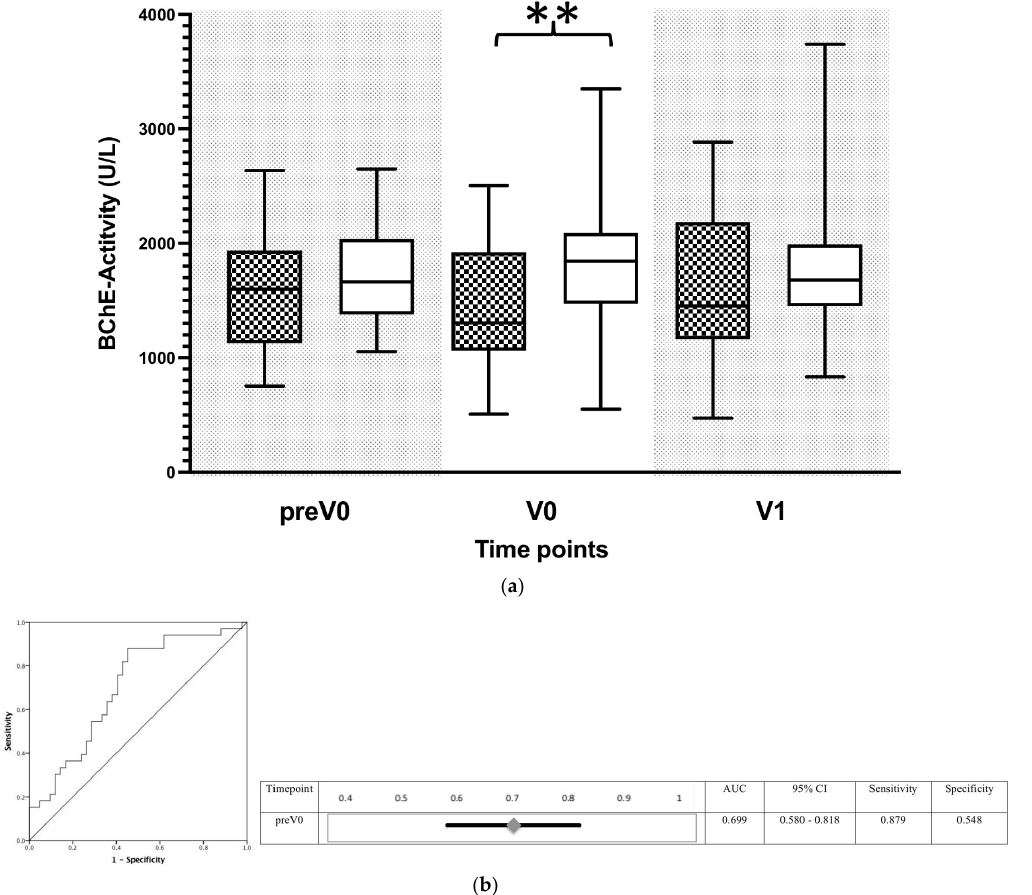
Figure 3. Plasma concentrations of butyrylcholinesterase (BChE) in patients following liver trans- plantation adjusted to the timepoint of bacterial infection. ( a ) Plasmatic BChE activity was measured in patients following liver transplantation. Measurements in patients with bacterial infection were adjusted to the timepoint of appearance (black squared box) and then compared to non-infected patients (white box). In patients with a bacterial infection, new timepoints were assigned by match- ing them to the first time of bacterial infection, whereas the control group without bacterial infection was assigned by matching them in an age- and sex-related manner to the same timepoints as pa- tients with a bacterial infection. The following virtual timepoints were created: the first measure- ment before the first bacterial infection (preV0), the plasma level at the time of bacterial infection (V0) and the next measured plasma level (V1). BChE activity is presented in kU/L. Data in box plots are given as median, 25th percentile, and 75th percentile, with the 10th and 90th percentile at the end of the whiskers. Concerning symbolism and higher orders of significance: p < 0.01: **, Mann– Whitney U Test. ( b ) Receiver operator characteristics (ROC)-analysis for BChE in bacterial infected vs. uninfected patients regarding the virtual timepoint V0 that is described above. Abbreviations: AUC, area under the curve; CI, confidence interval.